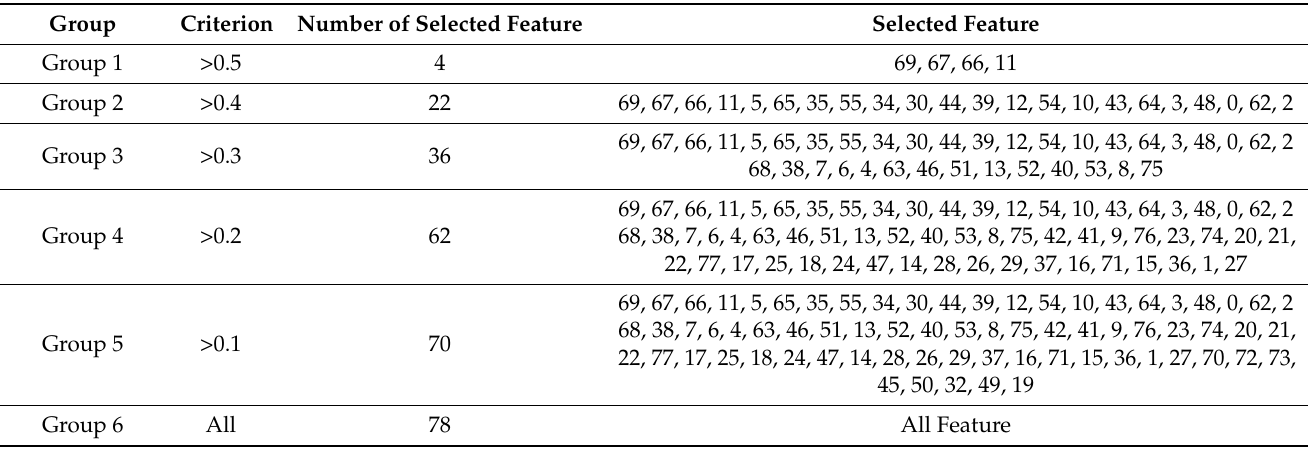
Table 4. Selected features by information gain